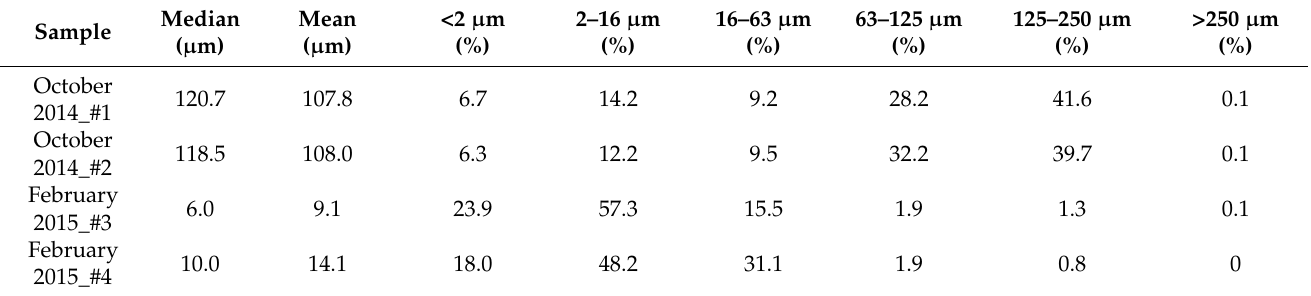
Table 2. Grain size characteristics of riverbed sediments in the study